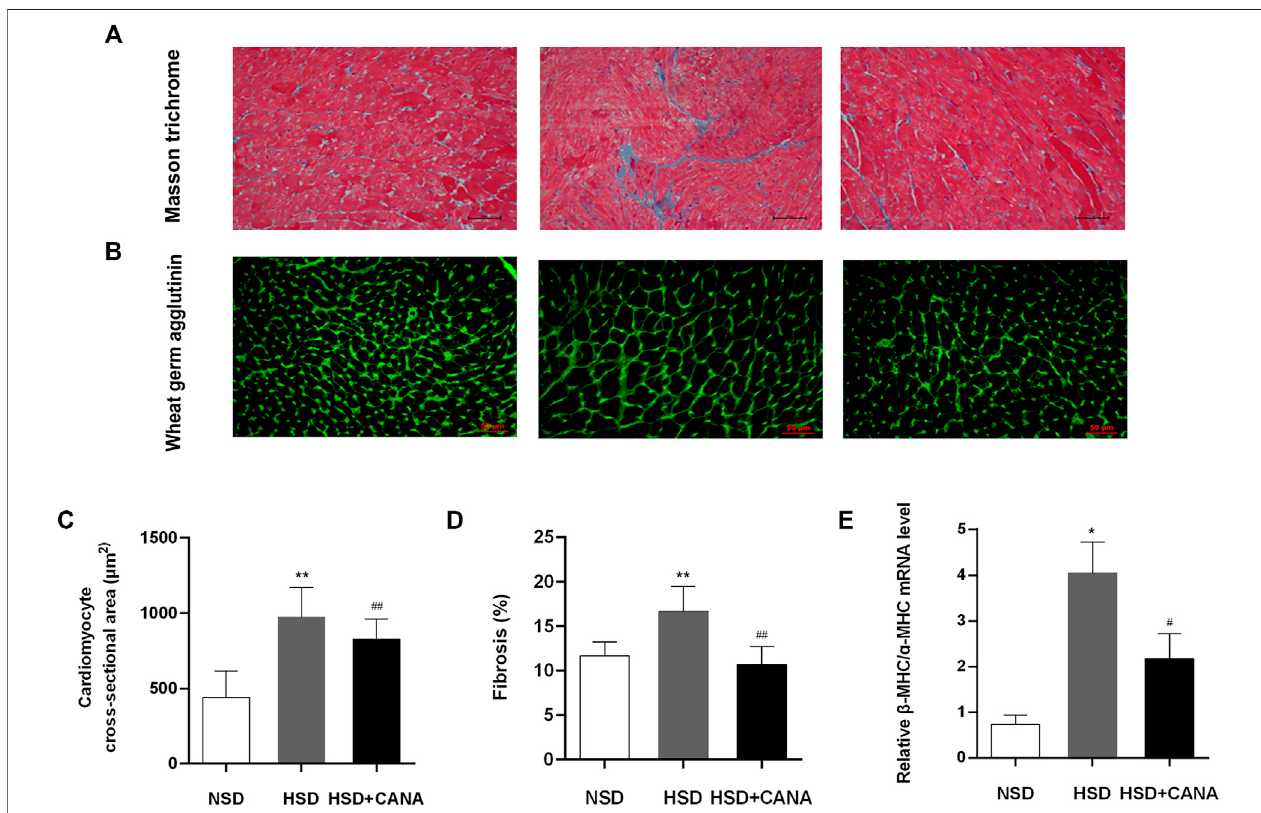
FIGURE 3 | Effect of CANA on cardiac histology and molecular markers for remodeling and fi brosis. (A) Representative left ventricular sections stained by Masson trichrome staining; (B) Representative left ventricular sections stained by WGA staining; (C) Quanti fi cation of the cardiomyocyte cross-sectional area from the wheat germ agglutinin (WGA)-stained section; (D) Quanti fi cation of fi brosis in the left ventricle from the Masson trichrome-stained section; (E) Measurement of mRNA levels to assess molecular markers for remodeling and fi brosis. NSD, normal-salt diet; HSD, high-salt diet. * p < 0.05, ** p < 0.01 vs. NSD. # p < 0.05, ## p < 0.01 vs. HSD.